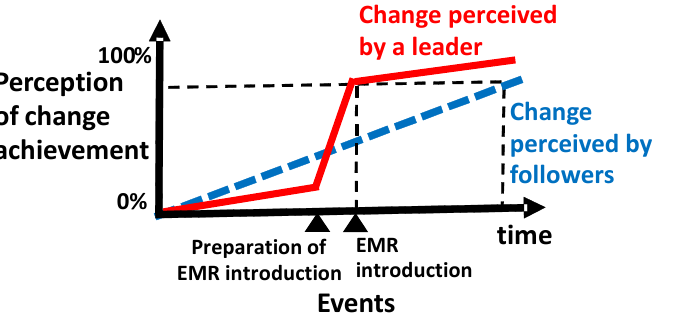
Figure 1. Perception gap of change at Otowa